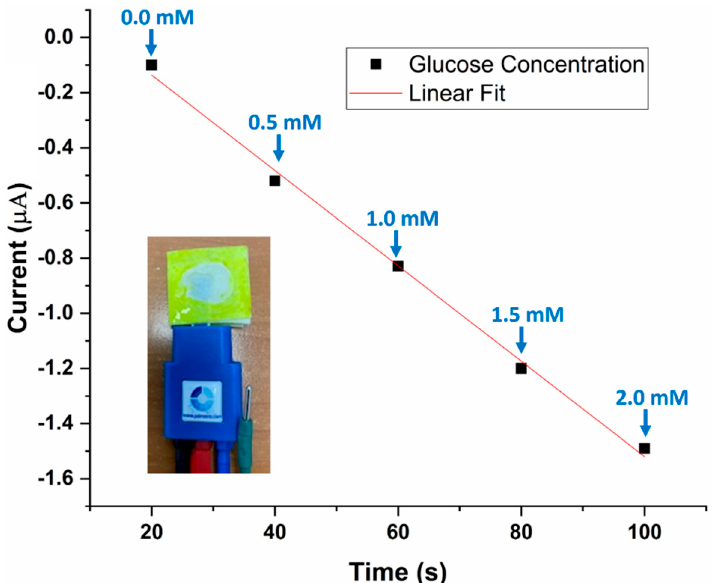
Figure 7. The linearity of the amperometric response of the glucose sensor at − 0.1 V (w.r.t the Ag/AgCl R.E) at different glucose concentrations (0 mM~2.0 mM, in 0.01 M PBS solution), added in increments of 0.5 mM at intervals of 20 s. Inset: Experimental setup with the glucose sensor.